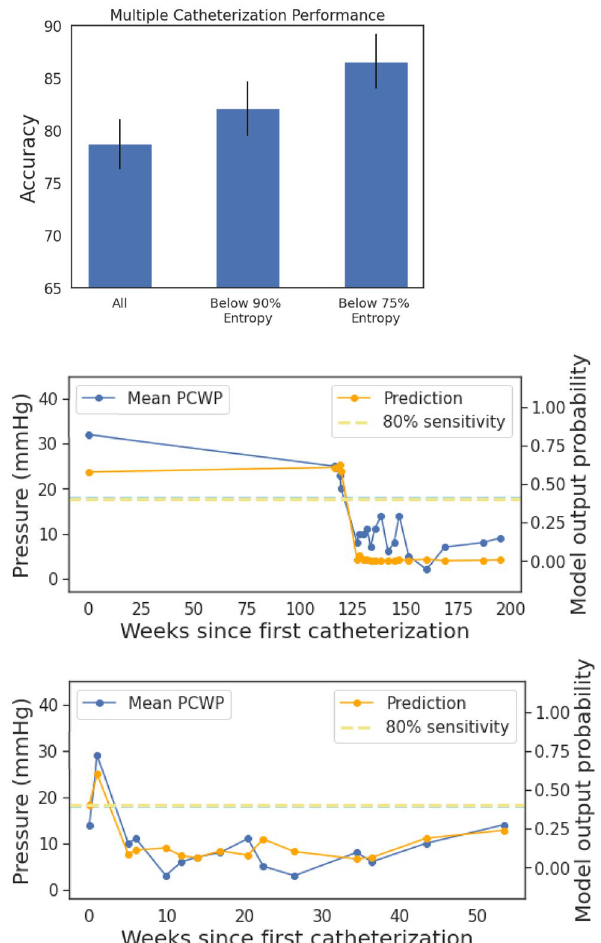
Figure 4. Performance on patients with multiple catheterizations. ( A ): Showing mean accuracy and standard error on sequences of catheterizations for patients at varying degrees of prediction uncertainty (N = 136). ( B , C ): Two examples of patients who had multiple catheterizations, showing measured mPCWP and model predictions. The blue dashed line corresponds to 18 mmHg mPCWP (left axis), and the dashed green line indicates the model output threshold corresponding to an 80% sensitivity